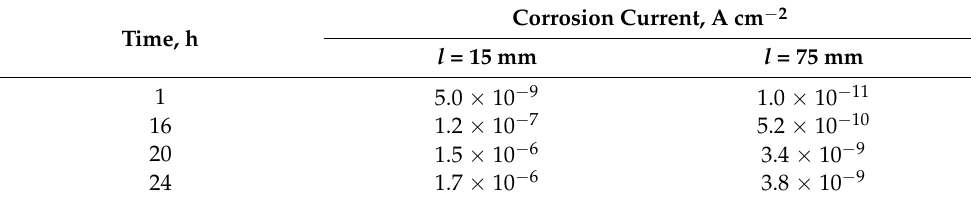
Table 3. Time evolution of corrosion current at different locations, l , along the gradient sample. Time,